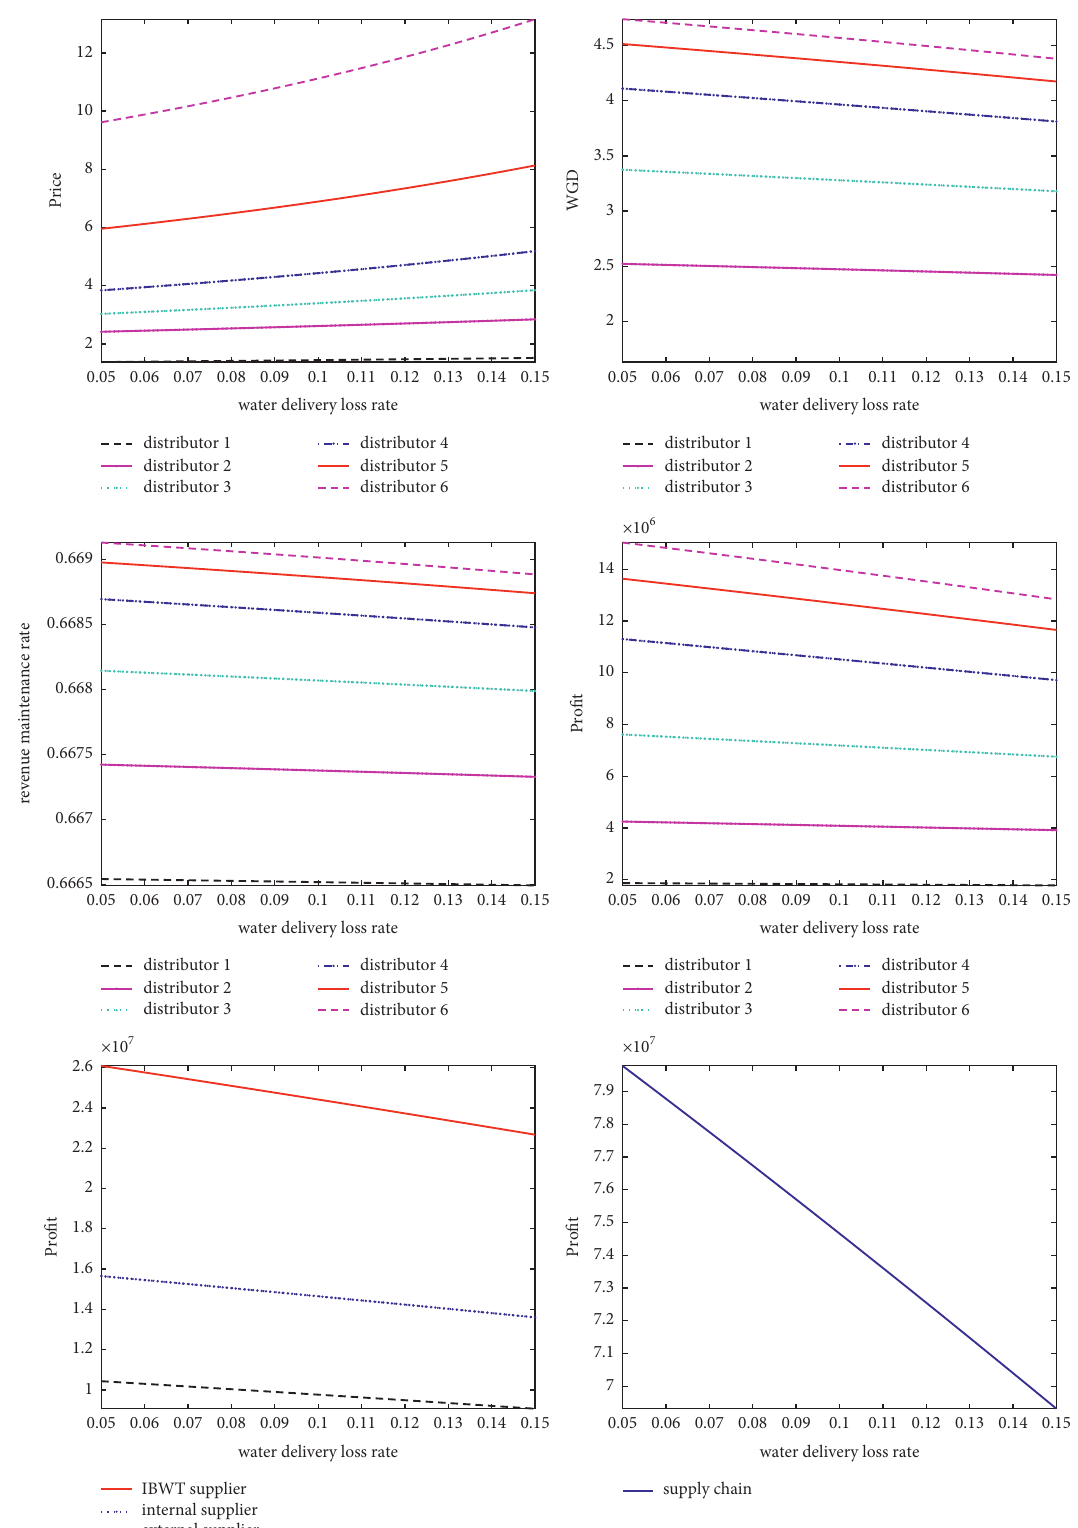
Figure 4: Sensitivity analysis of loss of water delivery rate ( δ